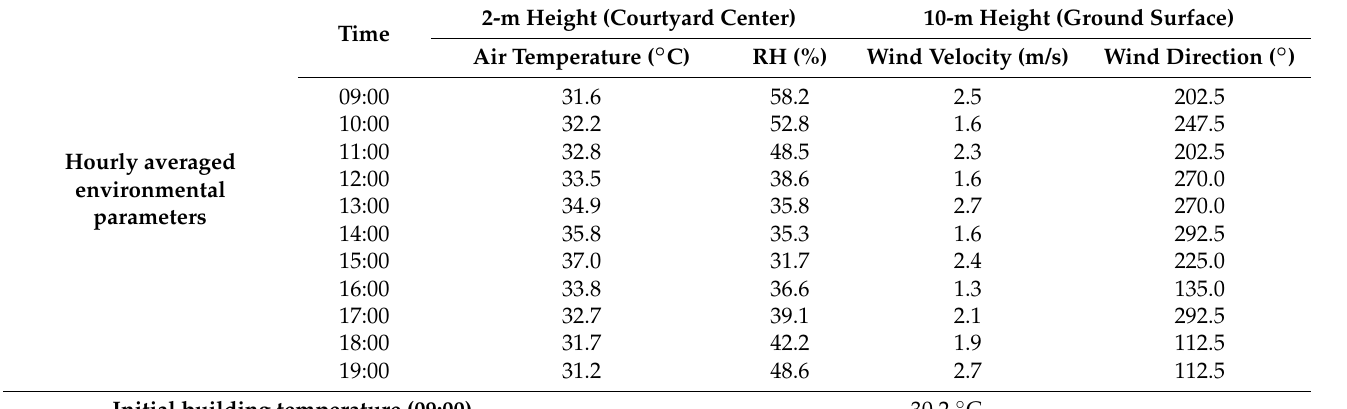
Table 4. Environmental parameters required by ENVI-met simulation.